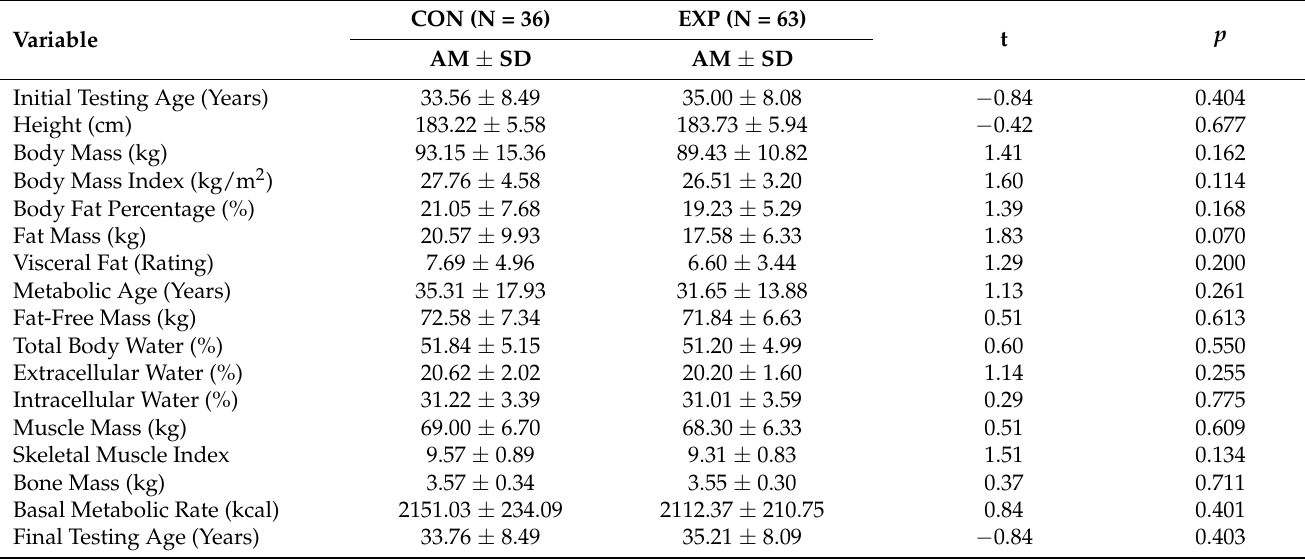
Table 3. Statistical significance of differences in arithmetic means ( t -test) of chronological age and anthropometric characteristics of the control and experimental groups in the initial measurement.